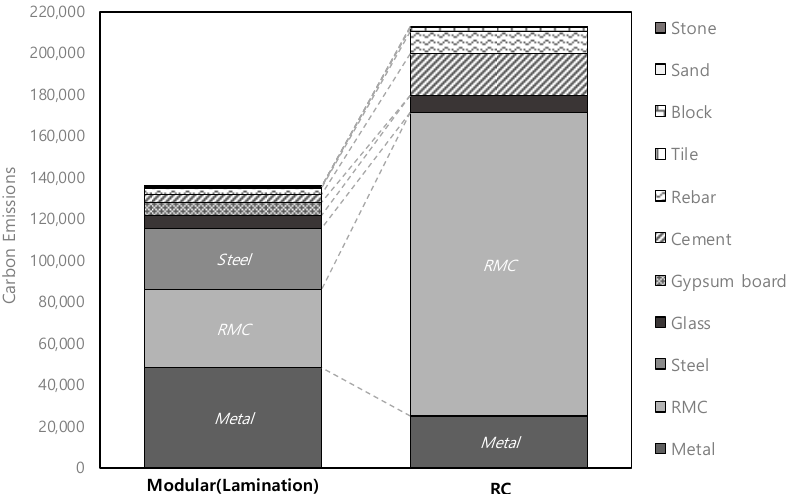
Figure 5. Comparison of the modular and RC building embodied carbon emissions.